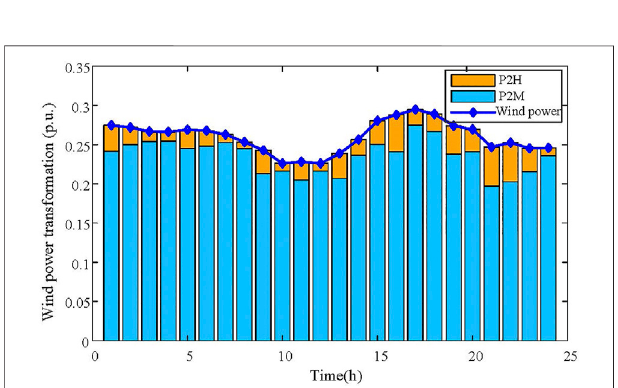
FIGURE 6 | Hydrogen production and conversion ef fi ciency through P2H and C2H. FIGURE7| Stackedbarchartofwindpowerconvertedtohydrogenand